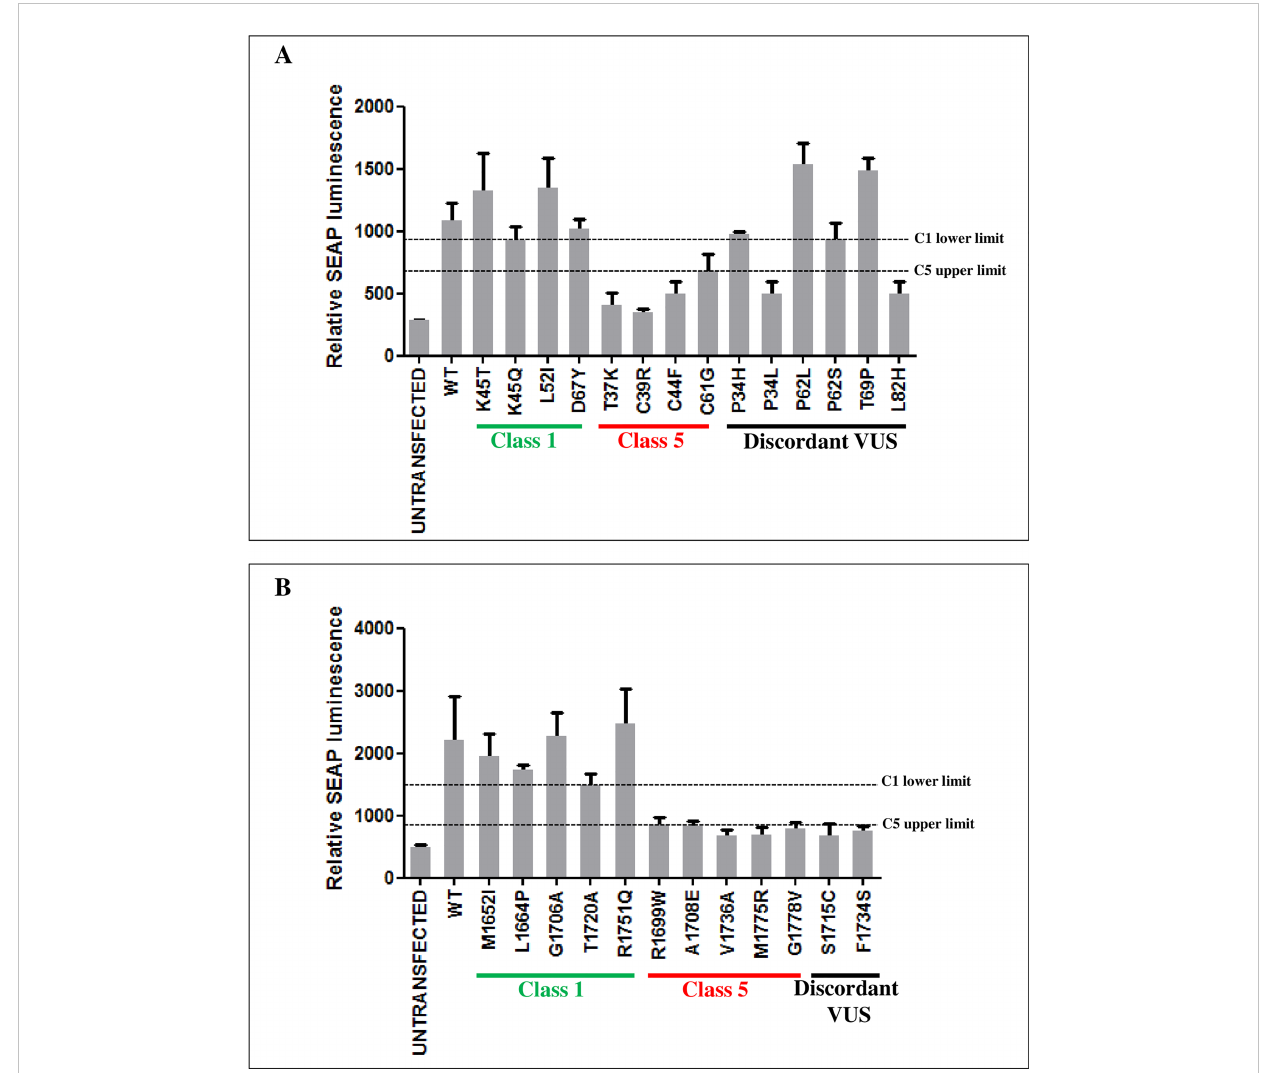
FIGURE 3 Functional evaluation of BRCA1 variants by M2H assay. The interaction strength of the BRCA1 RING domain with UbcH5a (A) and the BRCA1 BRCT domains with ABRAXAS (B) , in the presence of the indicated BRCA1 variants, was measured as SEAP expression levels. Each cell line was co- transfected in triplicate. The columns show the mean values of the three biological replicates. SEAP expression was evaluated 48h after transfection. Horizontal dotted lines represent the lowest relative SEAP luminescence level of class 1 variants (C1 lower limit) and the highest relative SEAP luminescence level of class 5 variants (C5 upper